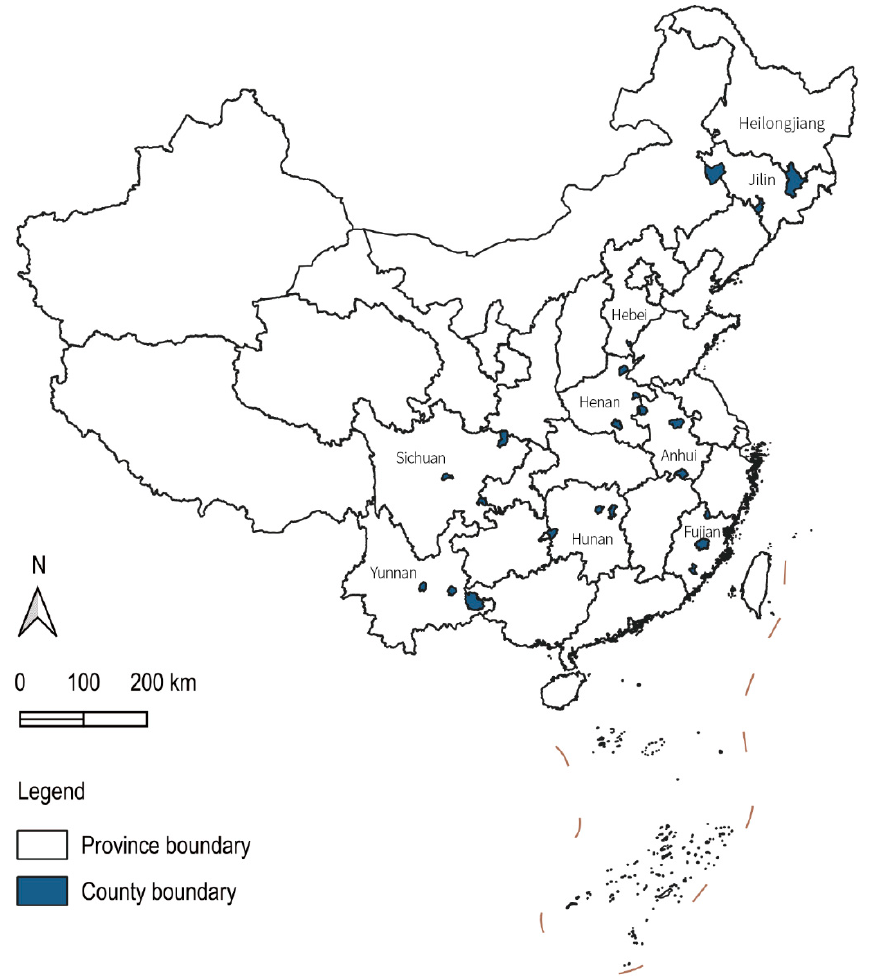
Figure 1. The geographical location of the study areas.